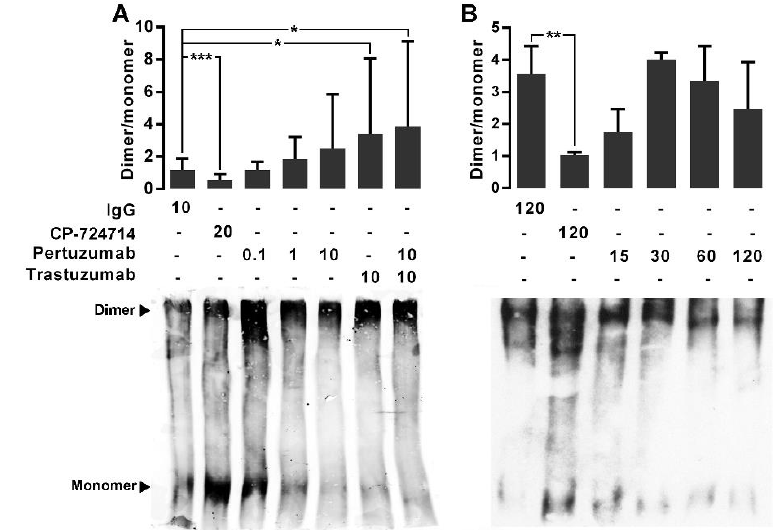
Figure 2. The effect of pertuzumab on HER2 homodimerization. ( A ) Immunoblot expression of monomer (185 kDa) and dimer (360–380 kDa) HER2 and quantified dimer/monomer ratios in CHO-K6 cells treated with 0.1, 1 and 10 μg/mL pertuzumab, 10 μg/mL trastuzumab or their combination for 60 min (dose-course treatment). ( B ) Time-course treatment of CHO-K6 with 10 μg/mL pertuzumab for 15, 30, 60 and 120 min. Ten μg/mL human IgG and 20 μM CP-724714 were used as mock and HER2 inhibitor controls. CP-724714 reduced dimer HER2. Trastuzumab increased dimer HER2 and pertuzumab had no significant effect on HER2 homodimerization. * p < 0.05, ** p < 0.01, *** p < 0.001.